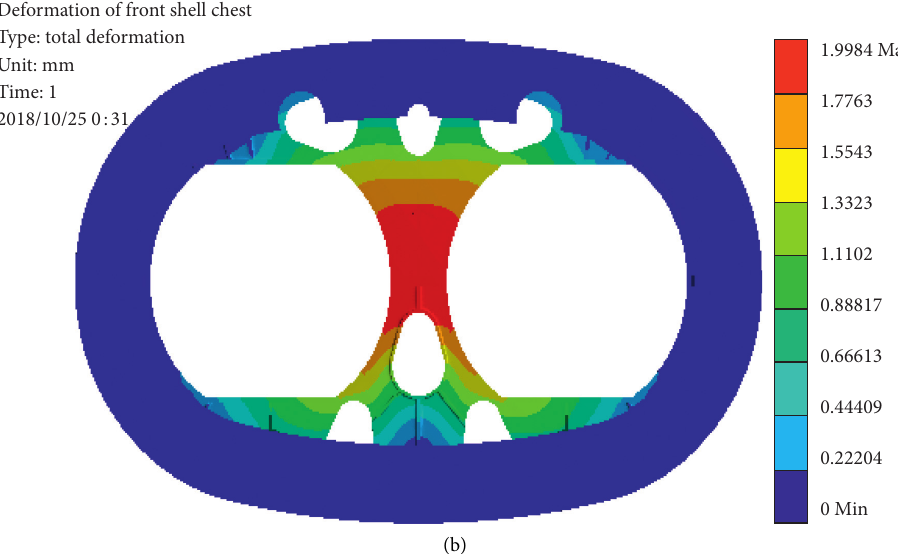
Figure 13: Finite element result. (a) Equivalent stress nephogram. (b) Total deformation nephogram.